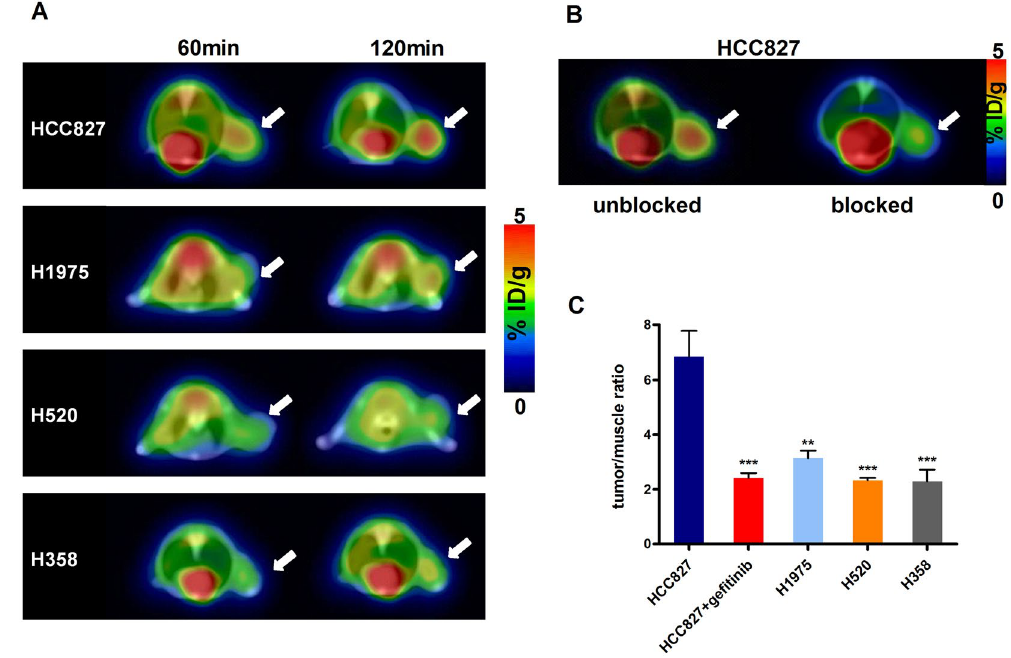
Figure 3. PET/CT imaging of HCC827, H1975, H358 and H520 xenografts with 18 F-IRS. ( A ) PET/CT images of HCC827, H1975, H358 and H520 tumor–bearing mice at 60 min, and 120 min after injection of 3.7 MBq (100 μ Ci) of 18 F-IRS(Axial view). Tumors (white arrow indicates tumor area) were clearly visualized after administration of 18 F-IRS in HCC827 xenografts while the other tumor types had negligible accumulation at 60 min and 120 min time points (white arrowsindicates tumor area). ( B ) After blocked by gefitinib (100 mg/Kg), little 18 F-IRS accumulated in the tumor (white arrow indicates tumor area) of HCC827 xenografts at 120 min. ( C ) Tumor/muscle ratios of 18 F-IRS in HCC827, H1975, H358 and H520 xenografts at 120 min after tracer injection. Data are presented as mean ± SD. ** P < 0.01 vs. HCC827 group. *** P < 0.001 vs. HCC827 group.